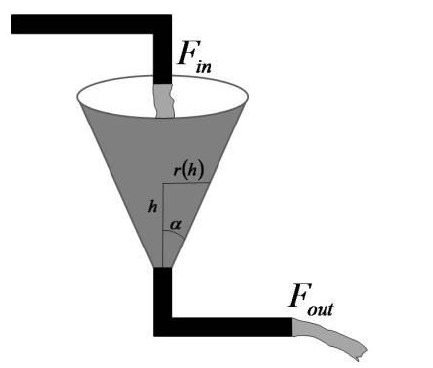
Figure 1. The liquid conical tank